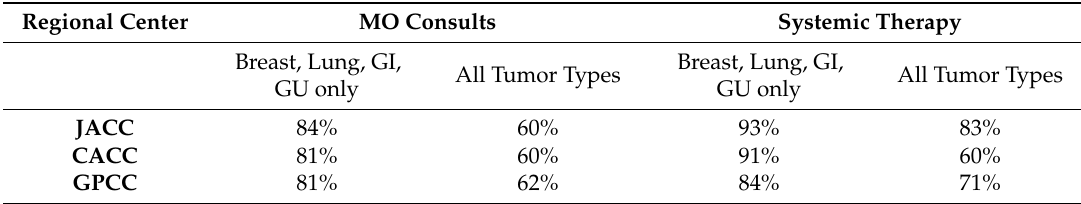
Table 2. New consults and treatments for systemic therapy according to CCTH in 2017.